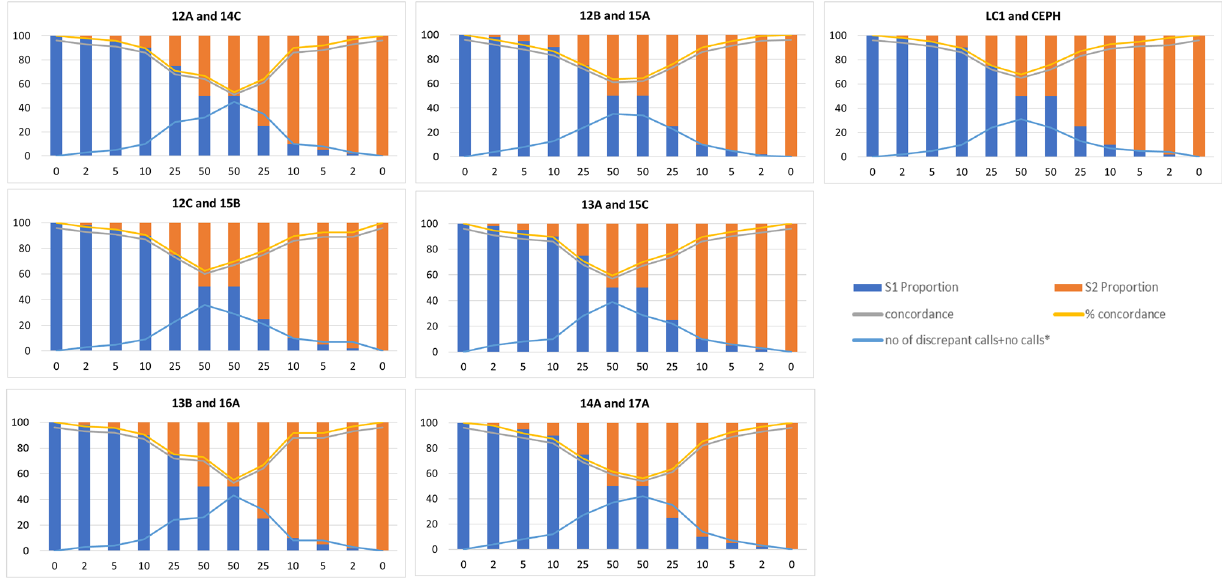
Figure 1. Concordance calls across the seven pairs of samples tested on the Fluidigm SNPtrace panel. The grey line indicates the concordant SNPs (N); the yellow line indicates the concordant SNPs (%); the blue line indicates the number of discordant plus no calls. Sample S1 is used as reference for the mixtures with S1 as the major component (blue) and the first 50:50 mixture; sample S2 is used as reference for the second 50:50 mixture and for the mixtures with S2 as the major component